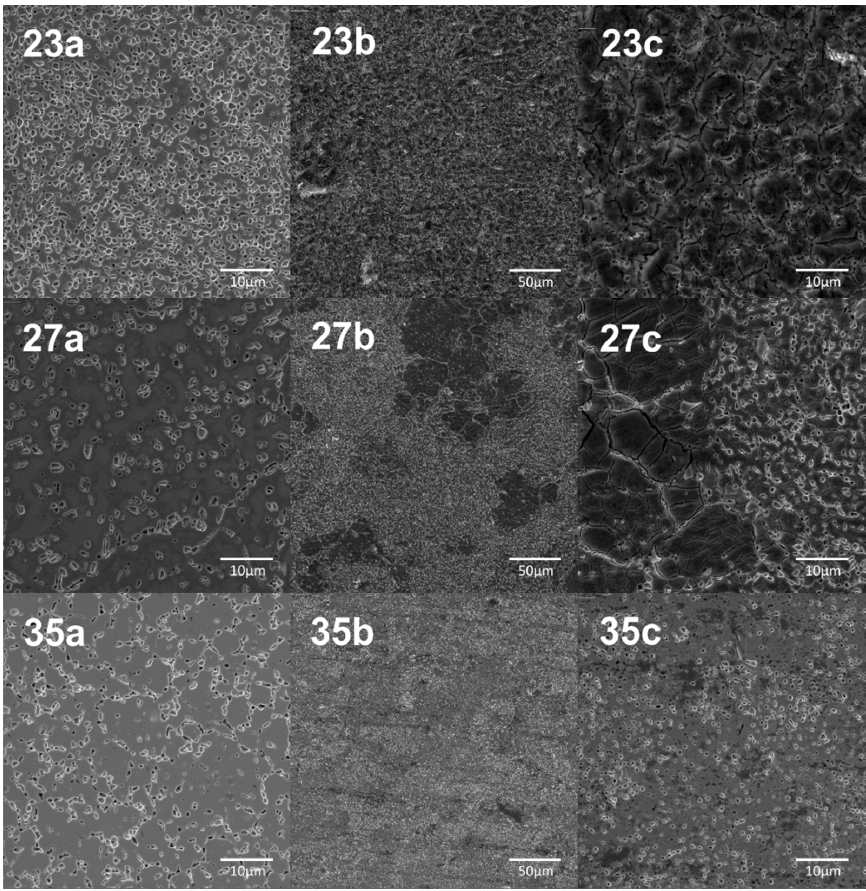
Figure 5. SEM microphotographs of Ti23Mo, Ti27Mo, Ti35Mo base materials—23a, 27a, 35a,